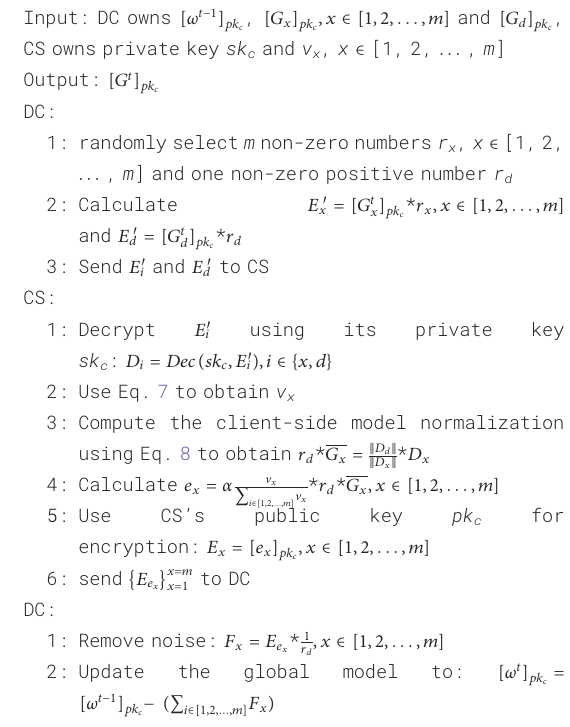
Algorithm 2. Safe Aggregation Based on Similarity and Normalized